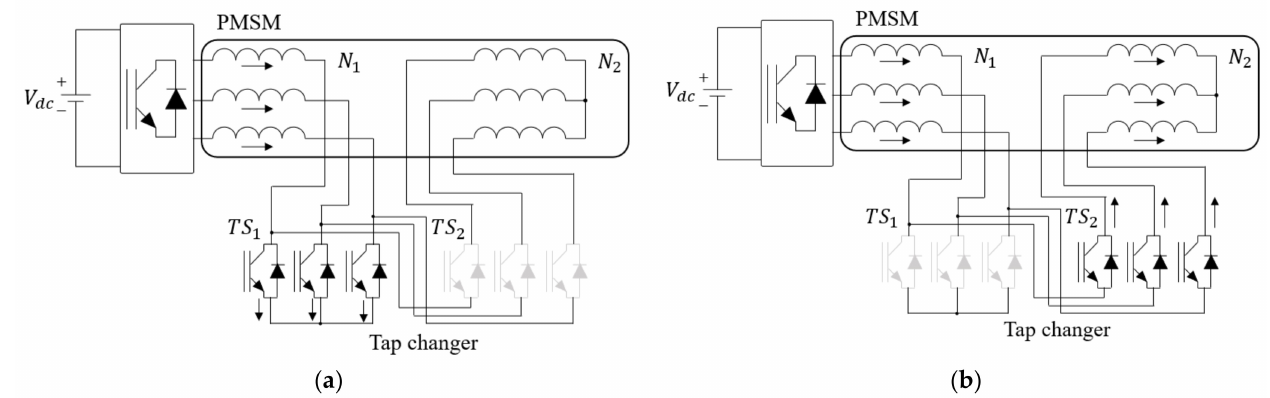
Figure 2. Tap-change motor configuration modes: ( a ) high-speed and ( b )